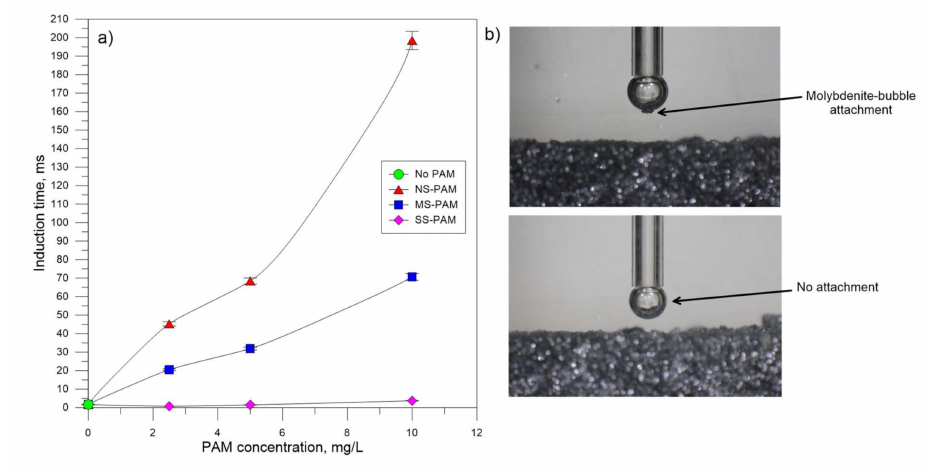
Figure 6. ( a ) Induction times as a function of NS-PAM / MS-PAM / SS-PAM concentrations and at pH = 9; ( b ) images of bubble-particles attachment.